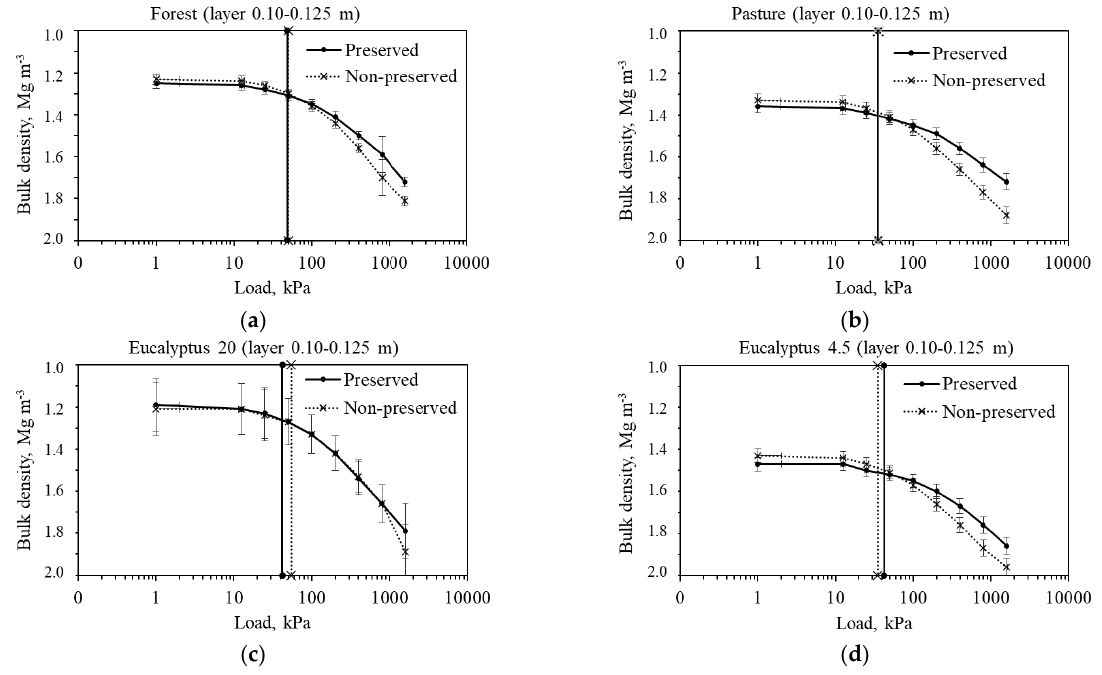
Figure 3. Soil compression curve for soil with preserved and non-preserved structure in the 0.10–0.125 m soil layer for four land uses. Vertical error bars for each pressure indicate the least significance difference, while vertical bars that accompany the superior and inferior axes in the figure indicate the precompression stress value for the preserved and non-preserved soil structures.